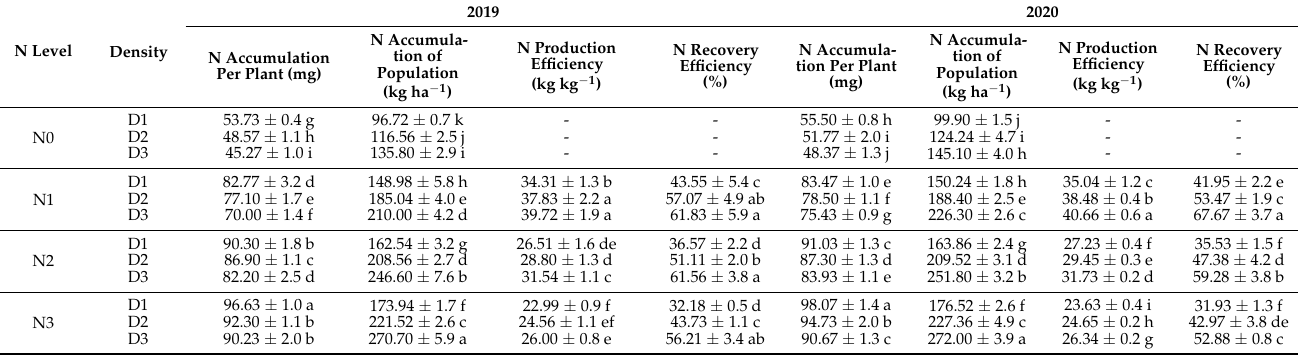
Table 7. The interaction of increasing density and decreasing N on N accumulation and N